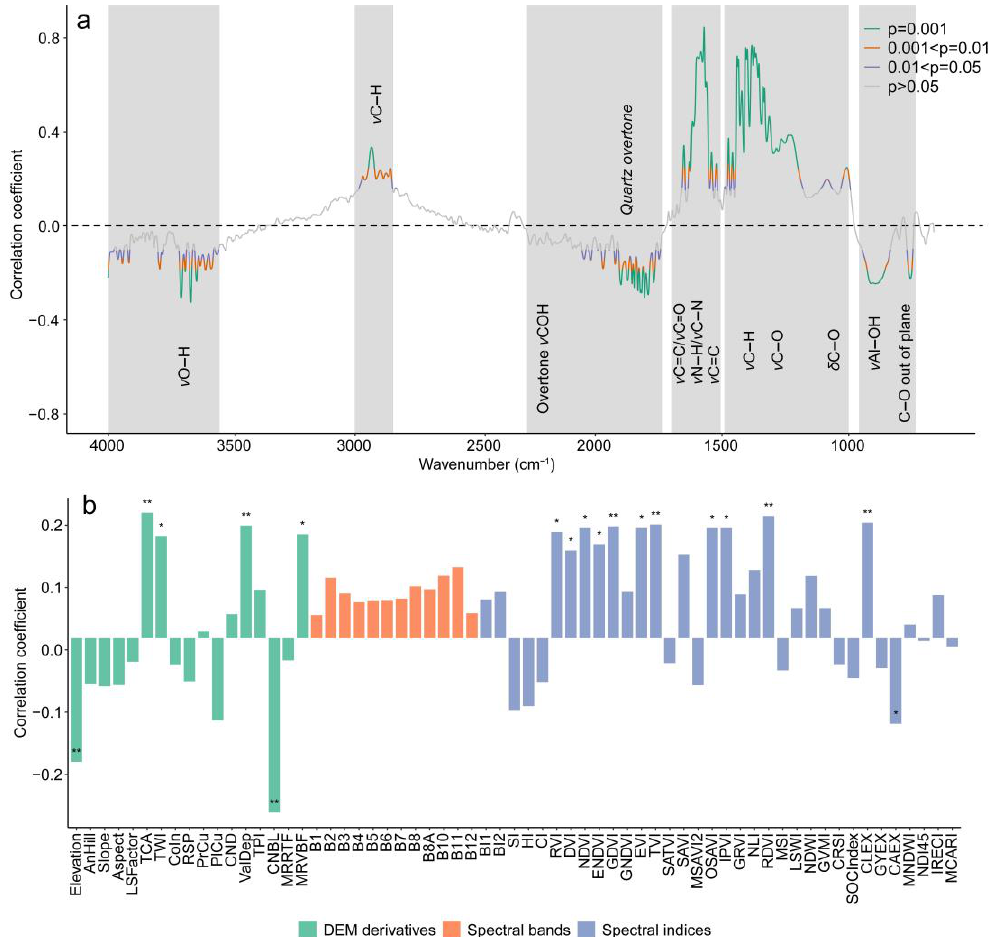
Figure 3. Pearson correlation between SOM content and FTIR-ATR spectral intensity ( a ) and Sentinel-2 spectral bands, indices, and DEM derivatives ( b ). The interpretation of the abbreviations can be found in Tables 1 and 2 and S1. Significance levels are denoted with * P < 0.05 and ** P < 0.01, respectively Table 3. Assignment of the characteristic bands in FTIR-ATR spectra.